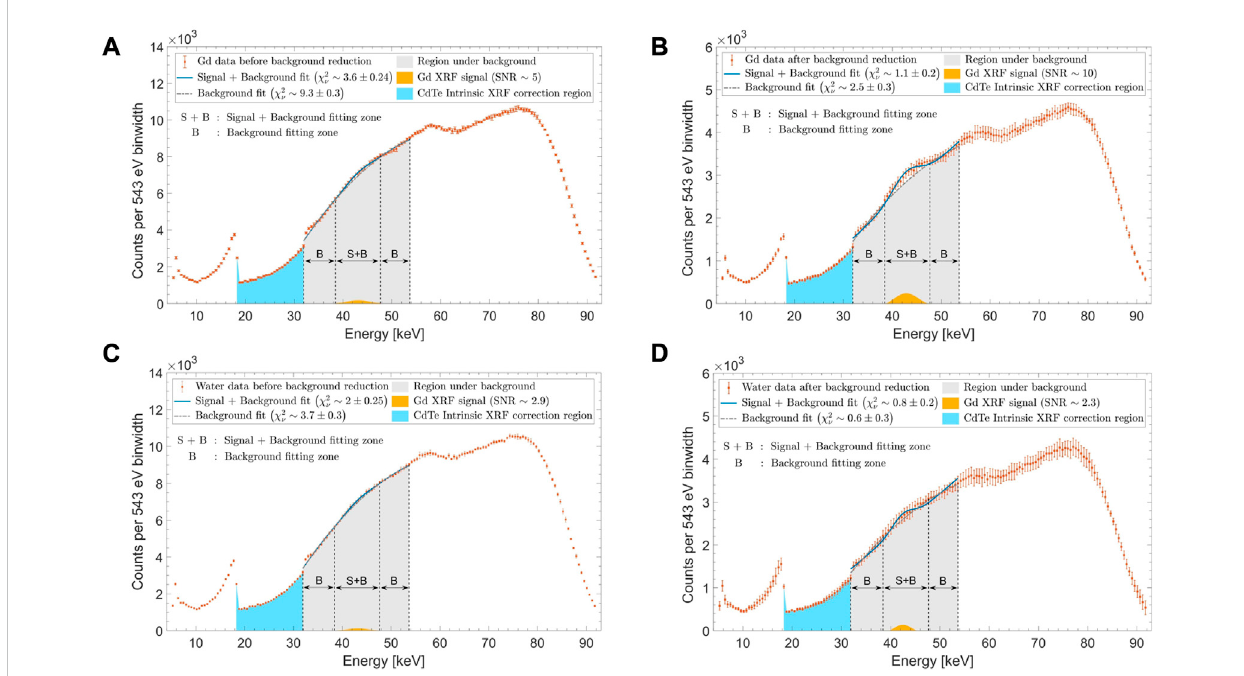
FIGURE 4 Typical XRF sum spectra (A,C) prior to and (B,D) post signal optimizations are shown here for (A,B) 1 mg/mL Gd concentration and (C,D) water background (0 mg/mL Gd concentration). An overall fi tting region (gray shaded area) is in the energy range of 32 – 53.5 keV. The background fi tting zone “ B ” is de fi ned in the energy range of 32 – 38.5 keV and 47.5 – 53.5 keV, while the signal plus background fi tting zone “ S + B ” is within 38.5 – 47.5 keV. The extracted Gd XRF signal (shown in yellow) is seen to have (A) SNR~5 before optimization and (B) SNR~10 post-optimization through background reduction and signal maximization. For water, (C) pre-optimization and (D) post-optimization SNRs were ~2.9 and ~2.3,